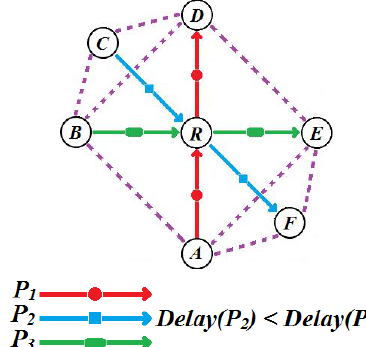
Fig. 2. Packet selection for coding based on end to end